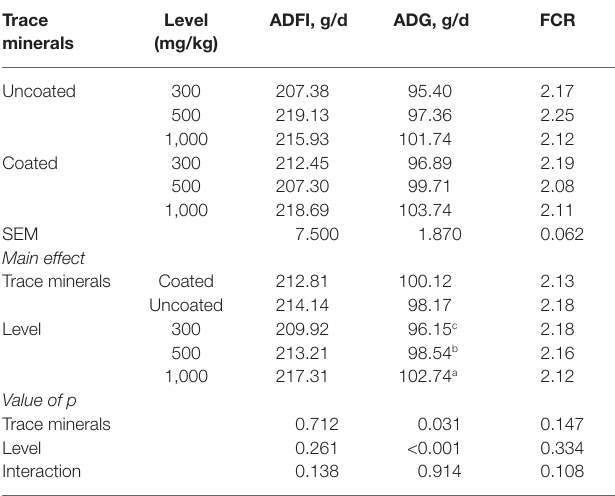
TABLE 2 | Effects of trace mineral type (coated or uncoated) and supplementation level (300, 500, or 1,000 mg/kg) of trace minerals on the growth performance of